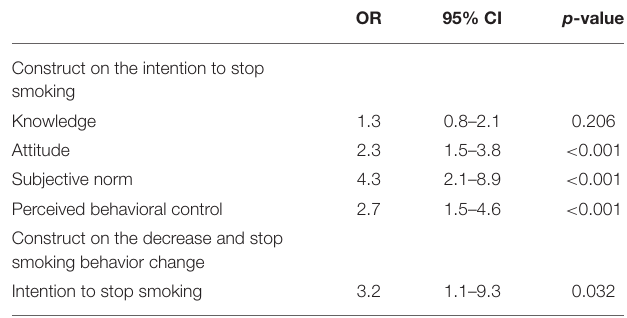
TABLE 5 | The construct of theory of planned behavior in the intention to stop smoking and smoking behavior change (among smokers, n = 102). n